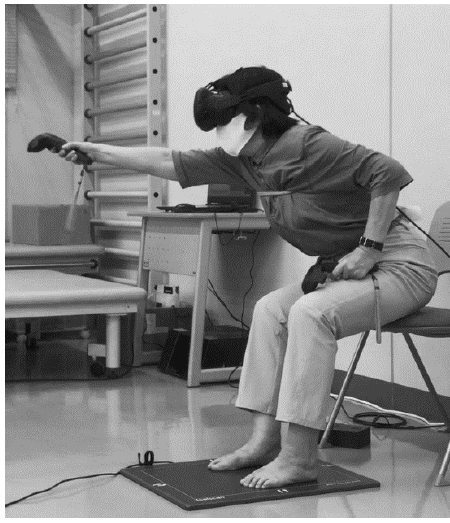
Figure 2. Images of the mediVR KAGURA-guided exercise.